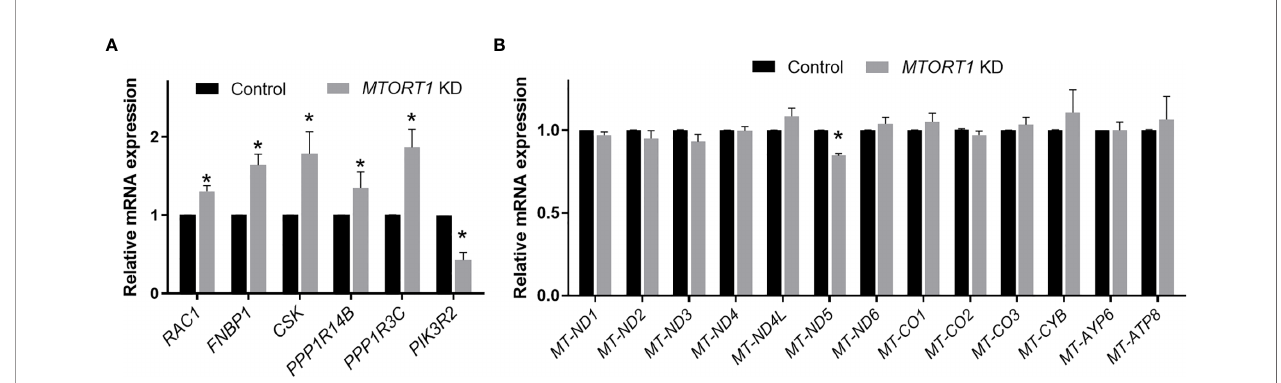
FIGURE 3 | Expression pro fi les of MTORT1 -downstream genes and mitochondrial genes in MTORT1 knockdown cells. Relative expression levels of selected MTORT1 -dwonstream genes (A) and mitochondrial genes (B) in MCF-7 cells treated with siRNA against MTORT1 were measured by quantitative RT-PCR and normalized to 18S rRNA (A) or 16S rRNA (B) . The results are means ± SDs (n = 3). * P